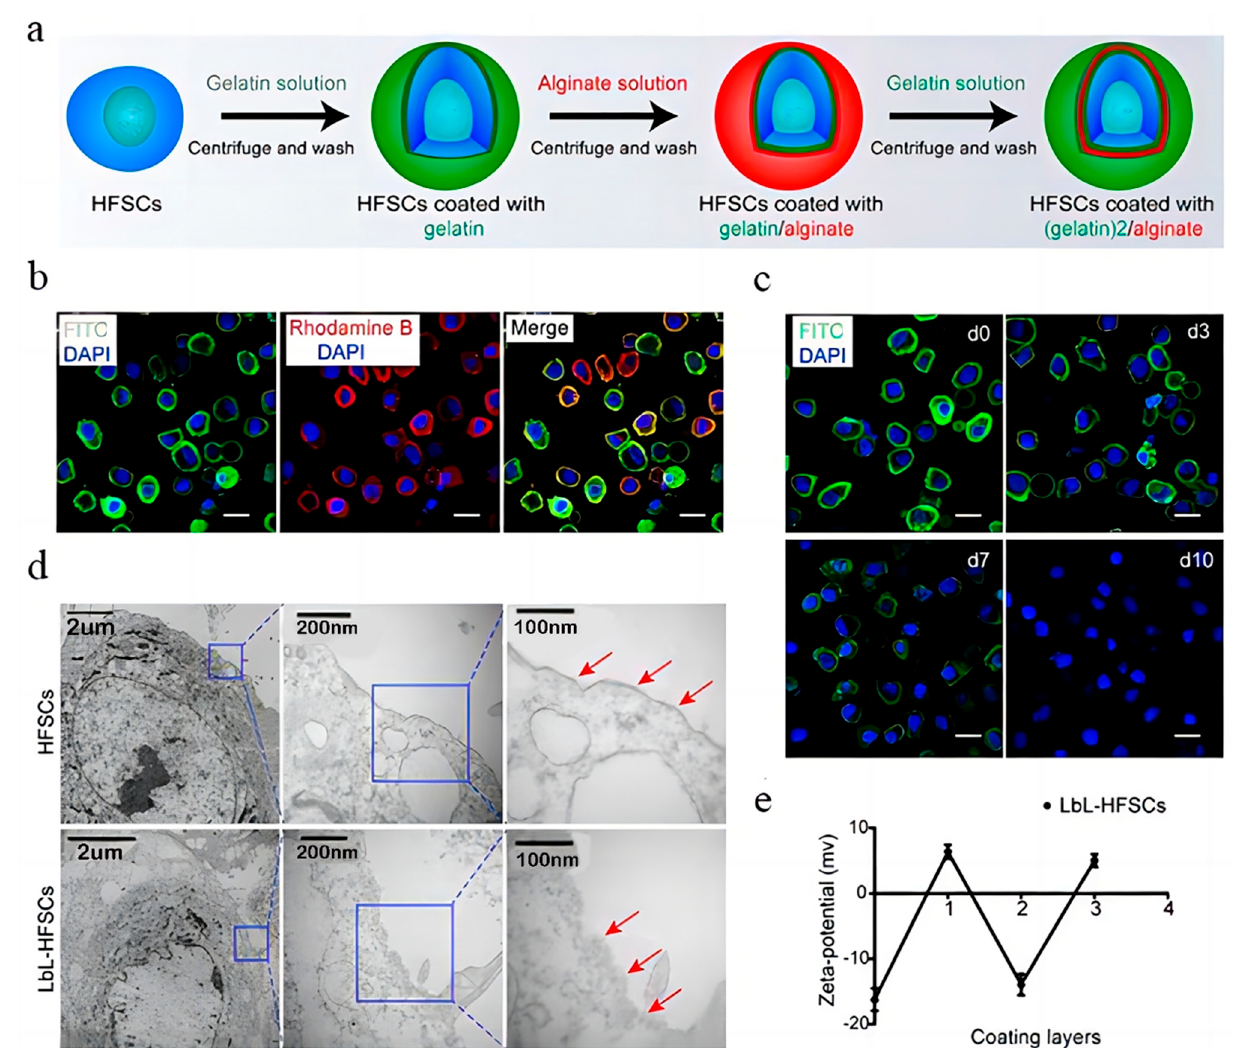
Figure 7. Generation of layer-by-layer − HFSCs (LbL-HFSCs) using the LbL cell coating technique. ( a ) Schematic illustration of LbL-HFSC fabrication using gelatin (green) and alginate (red) to coat HFSCs. ( b ) Confocal laser scanning microscopy (CLSM) images demonstrating an LbL coating on HFSCs; the cell surface was coated with gelatin − FITC (green) and alginate-rhodamine B (red). The cells were in suspension, and nuclei were stained with DAPI (blue). Scale bars: 10 µm. ( c ) Persistence of the biomaterial coated with LbL on the cell surface as shown by CLSM images. Scale bars: 10 µ m. ( d ) Transmission electron microscopy (TEM) images showing the comparison of uncoated and coated HFSCs. The arrows indicate coating materials on the cells’ surface. ( e ) Corresponding changes in zeta potential depending on the different layers of coating on the cell surface [72]. Copyright 2020 Ivyspring